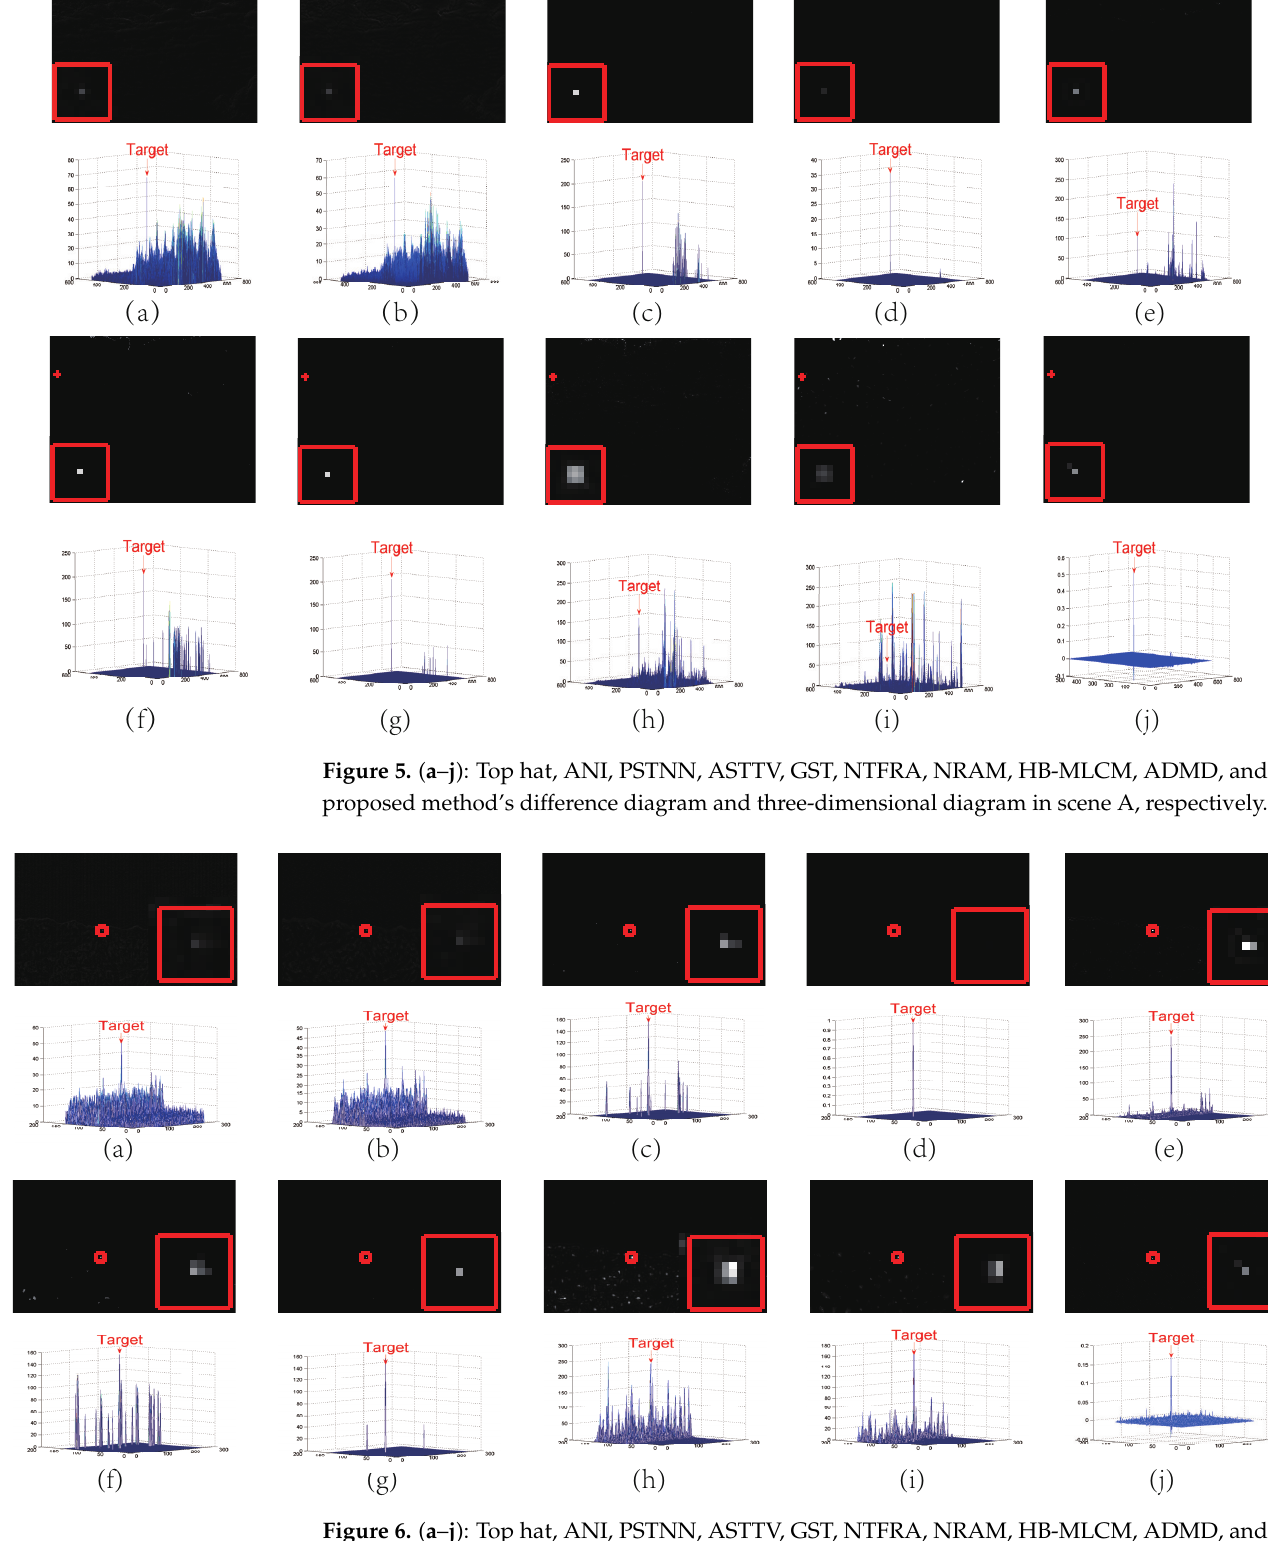
Figure 6. ( a – j ): Top hat, ANI, PSTNN, ASTTV, GST, NTFRA, NRAM, HB-MLCM, ADMD, and the proposed method’s difference diagram and three-dimensional diagram in scene B,